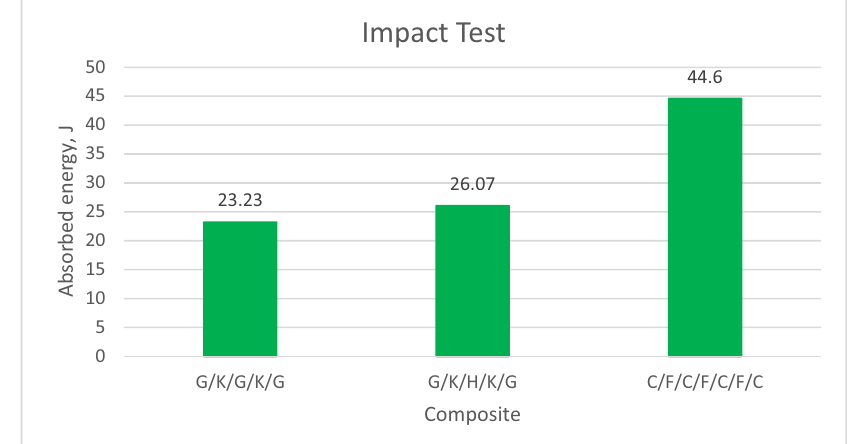
Figure 9: Comparison of absorbed energy by three di ff erent